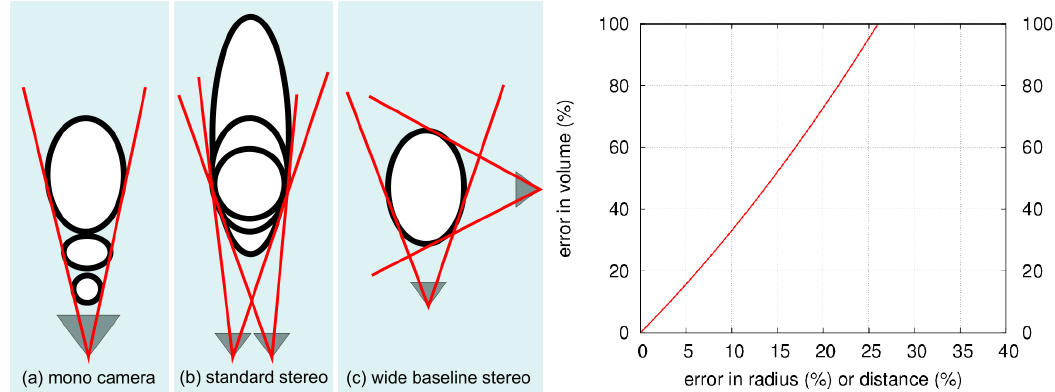
Figure 3. Different settings to observe bubbles: ( a ) For a monocular camera a large distant bubble looks the same as a small bubble closeby; ( b ) A small baseline stereo camera system can measure the distance of spherical bubbles, but the extent of ellipsoidal bubbles in viewing direction is very uncertain; ( c ) A wide baseline stereo system can determine the ellipsoidal shape